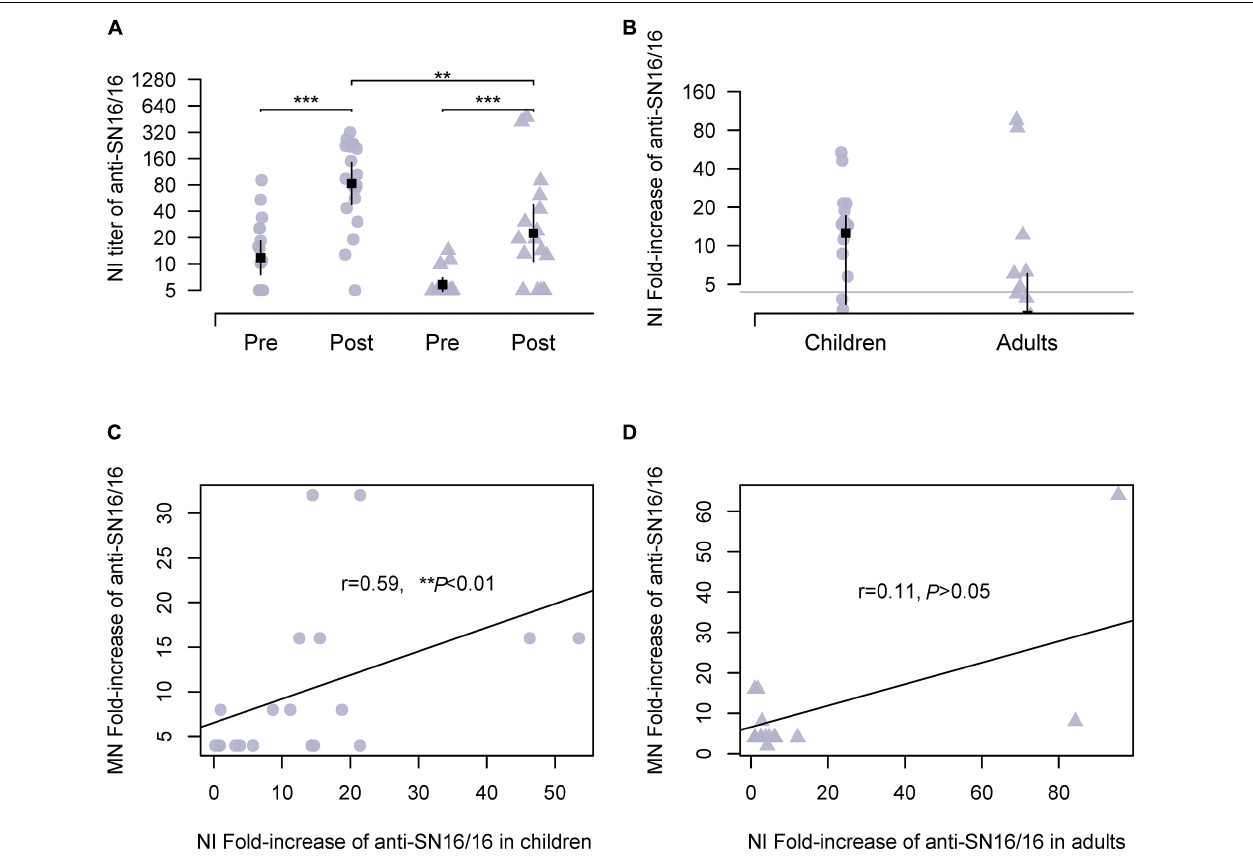
FIGURE 2 | NI Abs against circulating H3N2 virus during 2018/2019 flu season in studied children and adults and their correlations with MN Abs. Recombinant H6N2(RG) virus bearing N2 of SN16/16 was used for the NI test. (A) Ab titer of NI Abs in the paired sera against the RGH6N2-SN16/16. (B) Fold increase of NI Abs in paired sera against RGH6N2-SN16/16; the gray line is the level of 4; positive conversion is fold increase ≥ 4. (C,D) Correlations between MN Abs seroconversion and anti–RGH6N2-SN16/16 NI Abs in children and adults. (C,D) Are the regression line. The dot denotes children’s case, and the triangle represents adults. The mean ± 95% CI is shown. The r- and p -values are indicated. ** < 0.01, *** < 0.001.